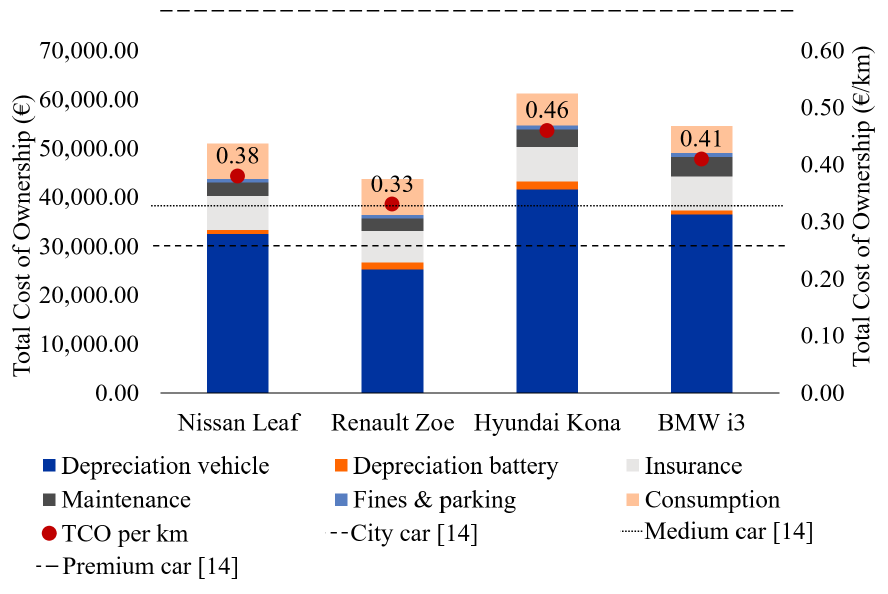
Figure 6. Standard TCO in a public charging case (source: own